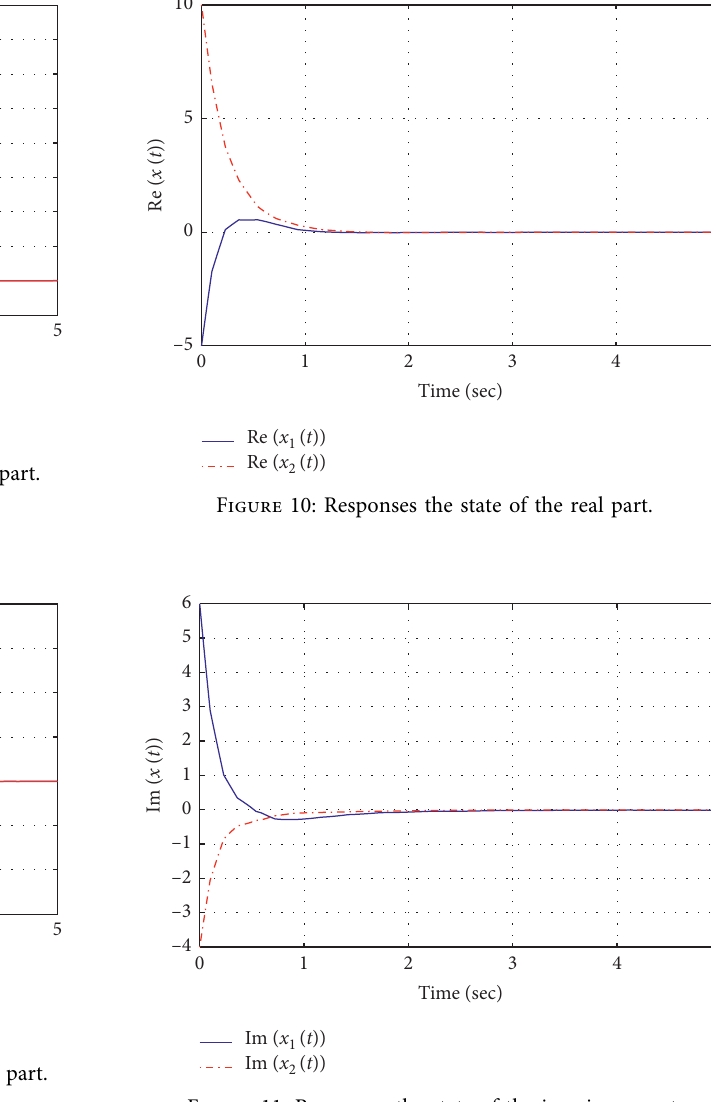
Figure 11: Responses the state of the imaginary part.